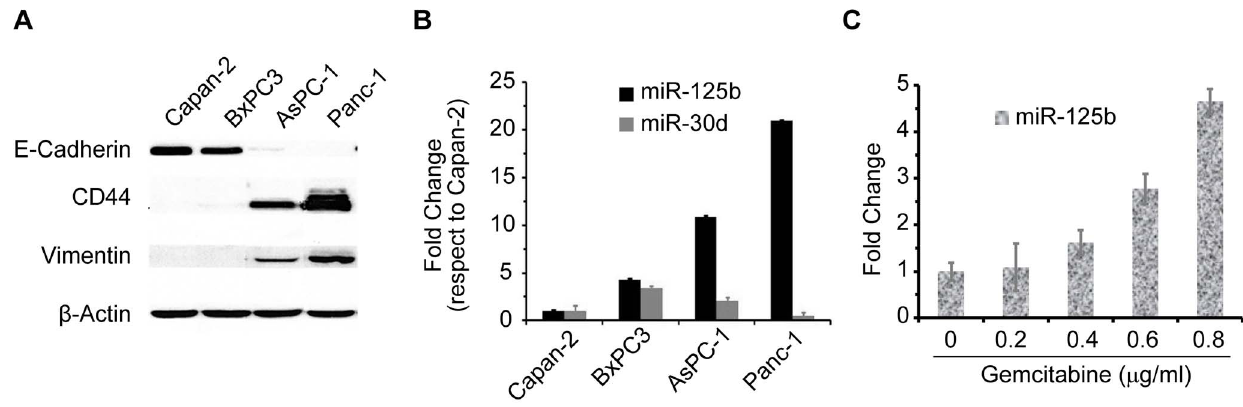
Figure 3. Micro-RNA-125b partially regulates CRMP. A. Western blot analyses showing the expression levels of EMT markers in PDAC cells in which miR-125b expression was determined. B. TaqMan qPCR analysis showing the relative expression of miRNAs (miR-125b and miR-30d) in different PDAC cells. MiR-30d is used as a control. C. Induction of miR-125b expression in BxPC3 upon treatment of gemcitabine. Quantitative PCR (TaqMan) were performed after 72 hrs of incubation with the drug in order to monitor the expression level of miR-125b in BxPC3 cells. Data indicates that expression of miR-125b is increased by the treatment of gemcitabine in a dose dependent manner.